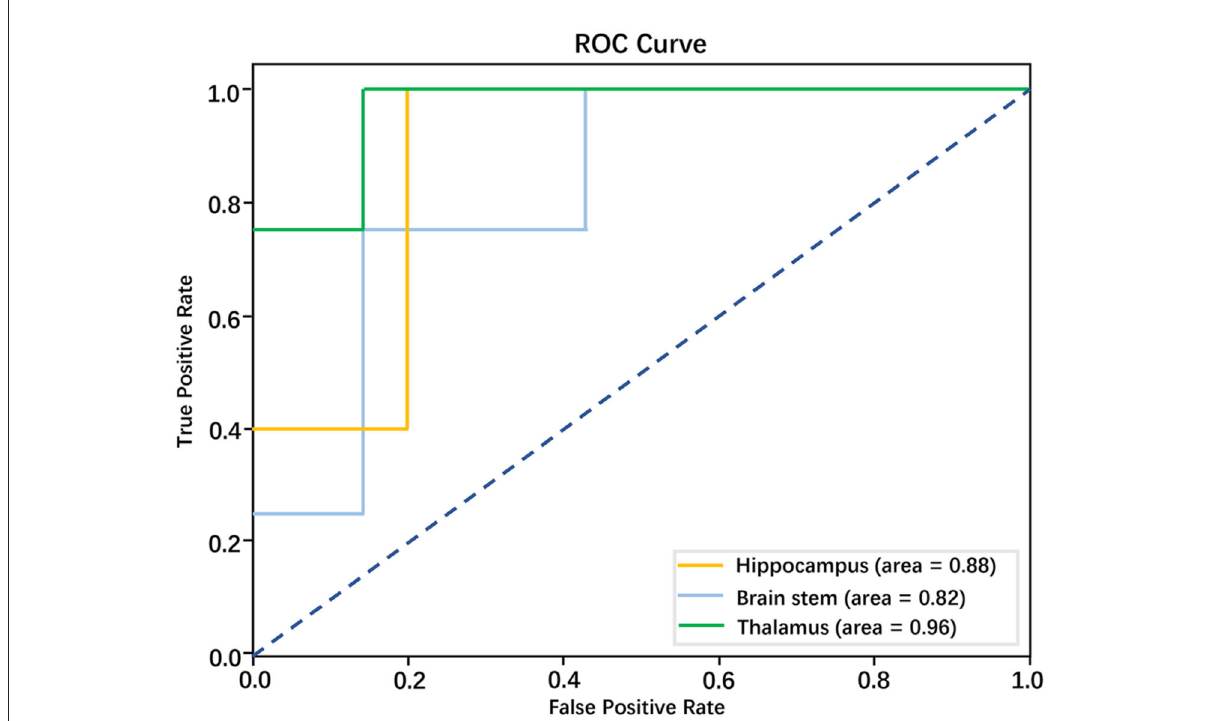
FIGURE3 Performance of models based on radiomics features in discriminating RAP level; the AUCs for these models were 0.88, 0.82, and 0.96,